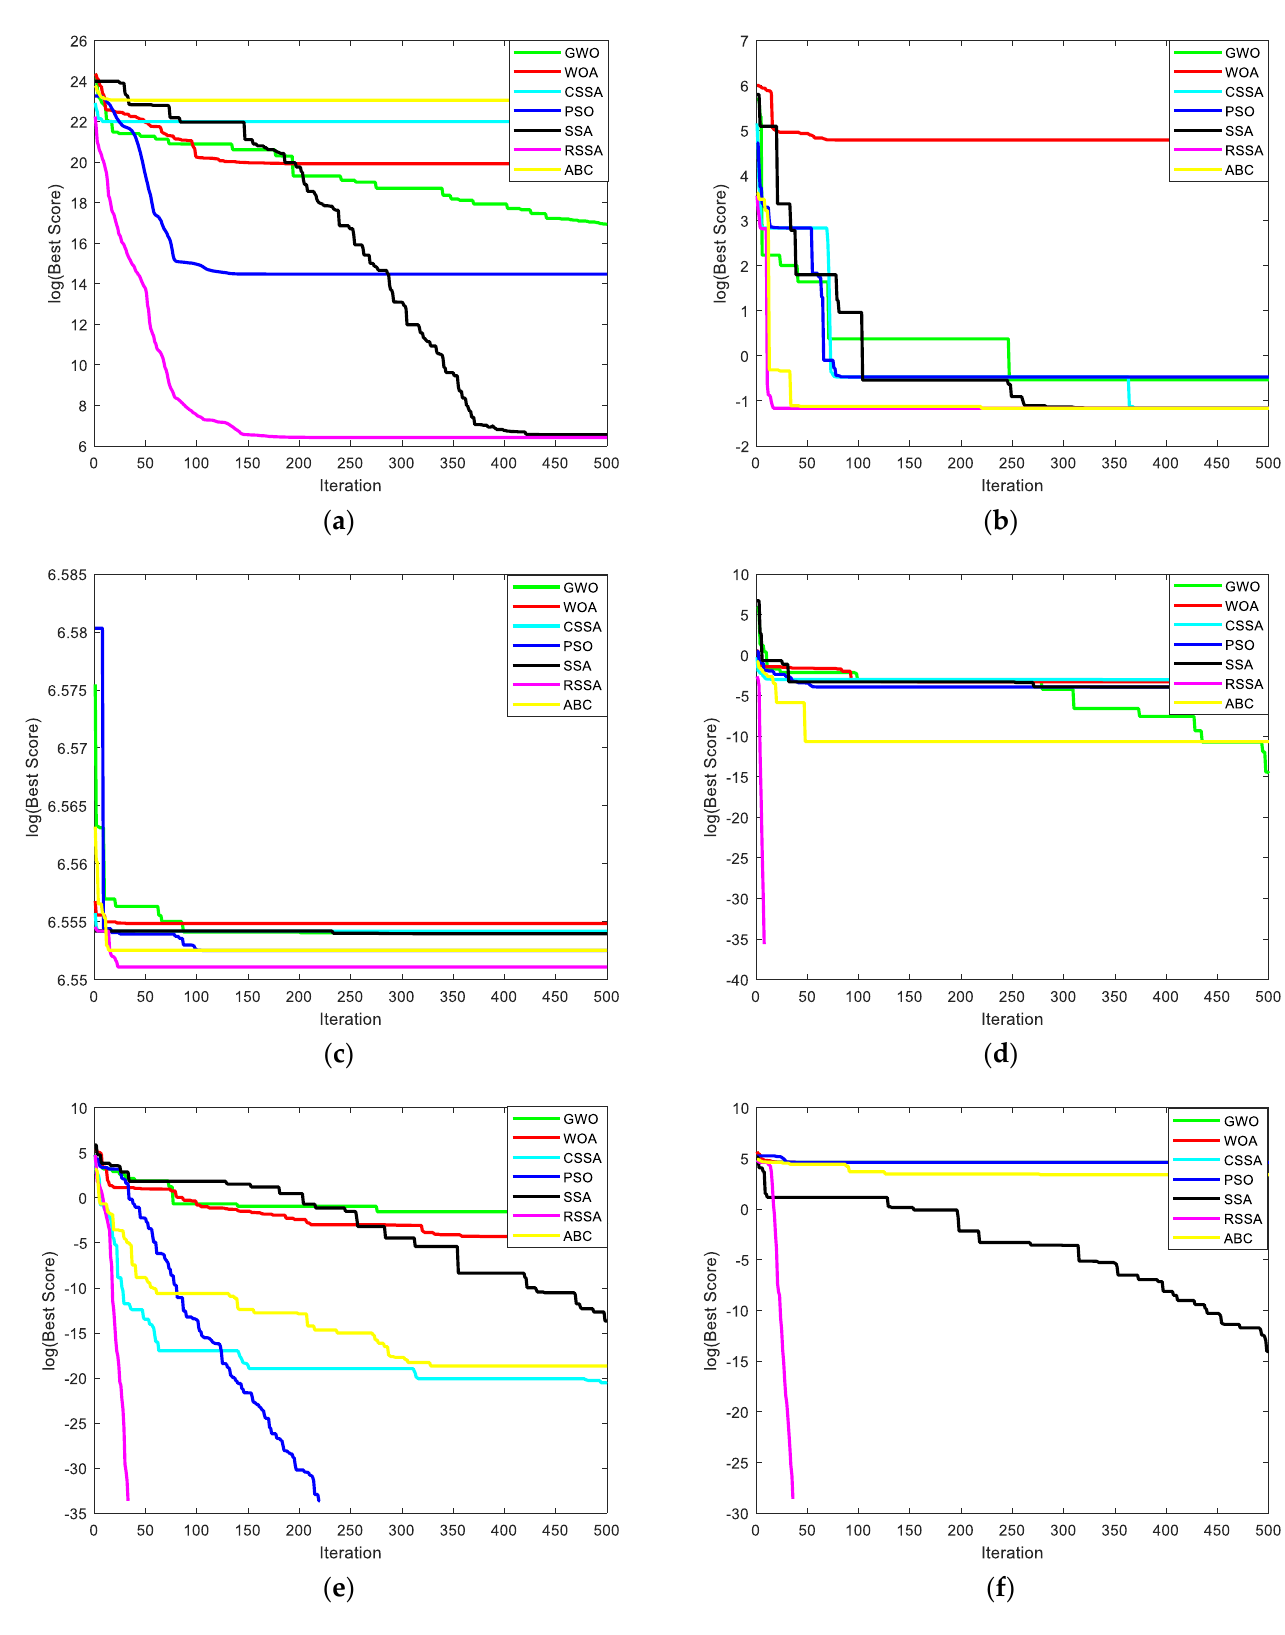
Figure 5. Convergence curves of six CEC − 2021 benchmark functions.